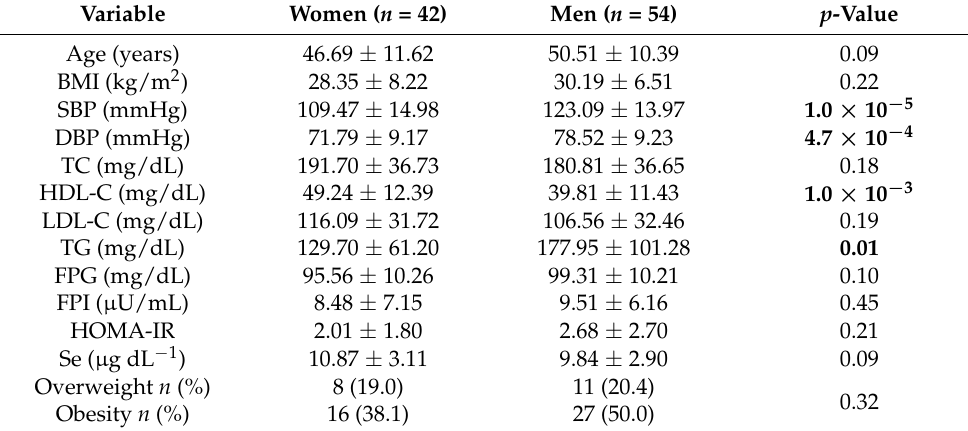
Table 1. General characteristics of the total sample.